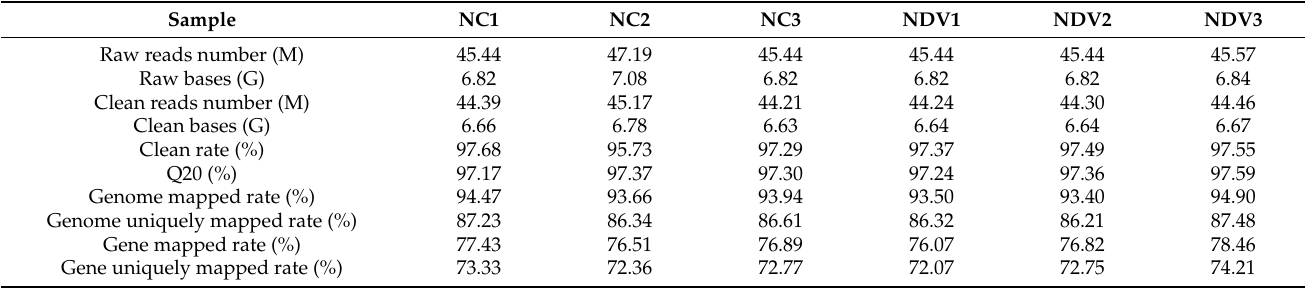
Figure 1. Study design and identification of DEGs between NDV and NC groups. ( A ) Experiment design for this study. ( B ) RTCA results of the Huh7 cells with different treatments. ( C ) Electropherograms of total RNAs isolated from the samples for deep sequencing. ( D ) Numbers of upregulated and downregulated genes identified in the NDV group compared to NC group. ( E ) Volcano plot displaying DEGs between NDV and NC groups. X-axis displays the value of log2 fold change, and the y-axis shows the -log10 (q-value). Upregulated genes are displayed by the red dots, downregulated genes are displayed by the blue dots, and the grey dots represent genes with no significant changes between NDV and NC groups. ( F ) PCA plot of DEGs. A dot represents a single sample, each group is represented by three replicates. Table 1. Overview of the RNA-seq and genome/gene mapping